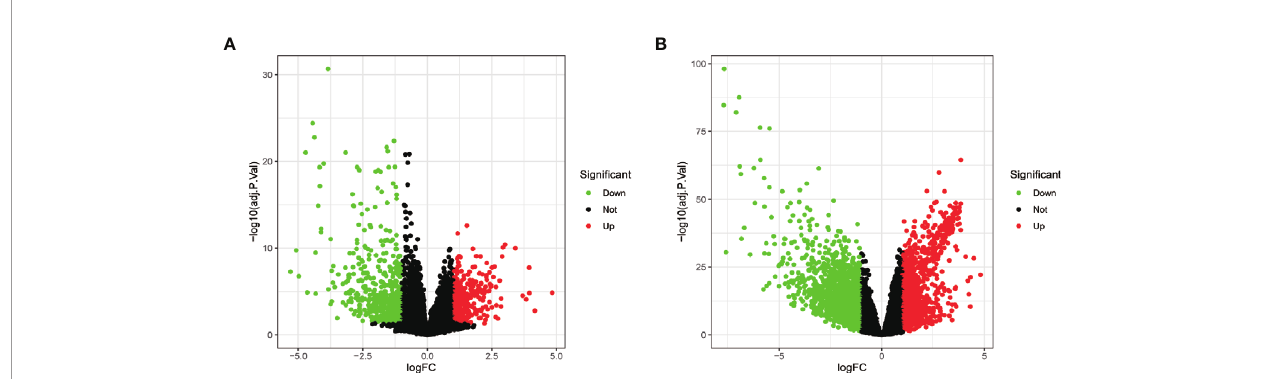
FIGURE 2 | The volcano plot of DEGs in patients with HCC. (A) Volcano plot of DEGs in the GSE62232 dataset. (B) Volcano plot of DEGs in the TCGA dataset. Up-regulated genes and down-regulated were represented in red dot and green dot respectively.